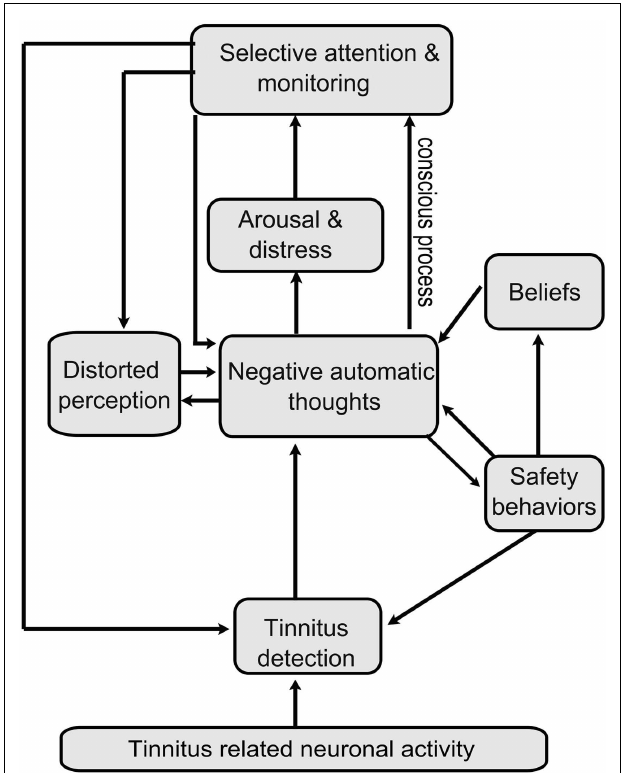
FIGURE 1 |A cognitive model of tinnitus distress . Representation of the novel cognitive-behavioral model of tinnitus distress.Tinnitus provokes distress when a person holds overly negatively thoughts about it.These negative thoughts provoke arousal and emotional distress and motivate maintaining factors such as selective attention, monitoring, and counterproductive safety behaviors.These processes result in the patient overestimating the intensity and complexity of tinnitus, i.e., patients gain a distorted perception of tinnitus. Distorted perception is also fueled by overly negative thoughts of tinnitus. A number of feedback loops are involved: selective attention and monitoring leading to greater detection of tinnitus, to further negative appraisal; distorted perception of tinnitus leads to further negative appraisal and we tentatively hypothesize that negative appraisal contributes to distorted perception. In many cases, safety behaviors adopted to cope with the perceived threat inadvertently maintain or exacerbate existing worry and in many cases also directly alter the detection of tinnitus, e.g., by manipulating environmental sounds. Beliefs about tinnitus also fuel negative thoughts. Such beliefs are based on experience of tinnitus in others or derive from general beliefs about health, the self, or the world. Both conscious and involuntary processes are involved but the model emphasizes conscious processes as these constitute the main therapeutic